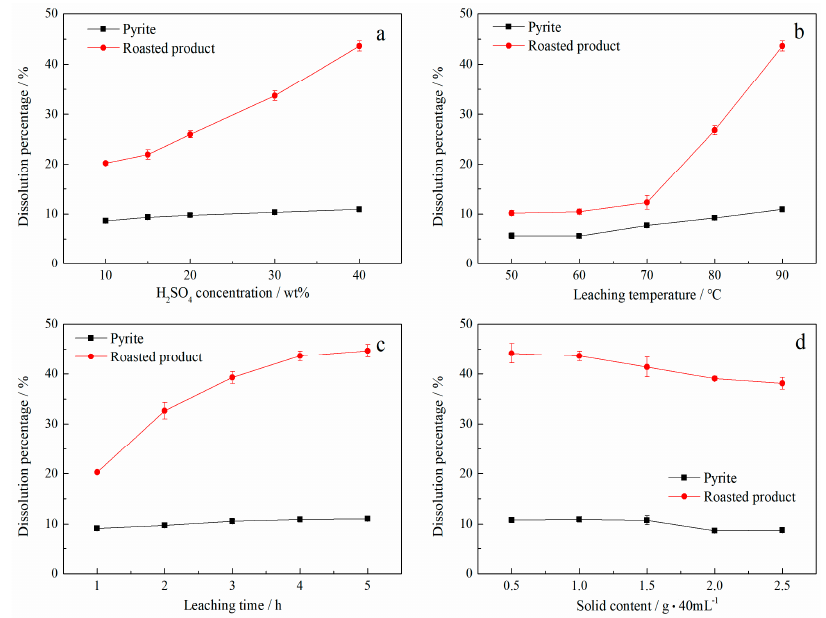
Figure 4. The dissolution of pyrite and its roasted product at different conditions. Variables: ( a ) the H 2 SO 4 concentration; ( b ) the leaching temperature; ( c ) the leaching time; ( d ) the solid content.